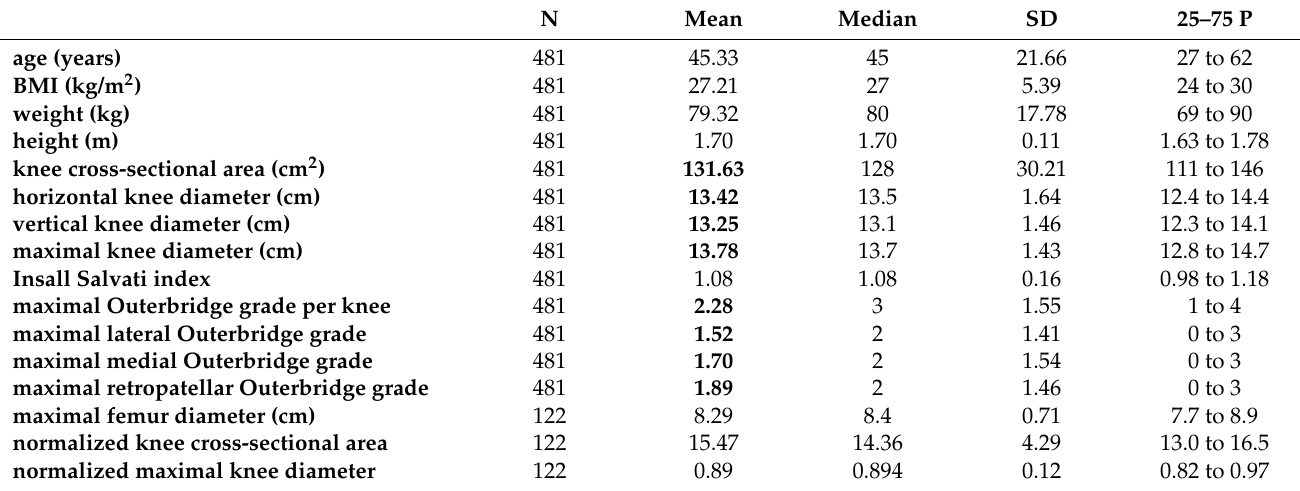
Table 3. Summary of non-binary variable statistics.